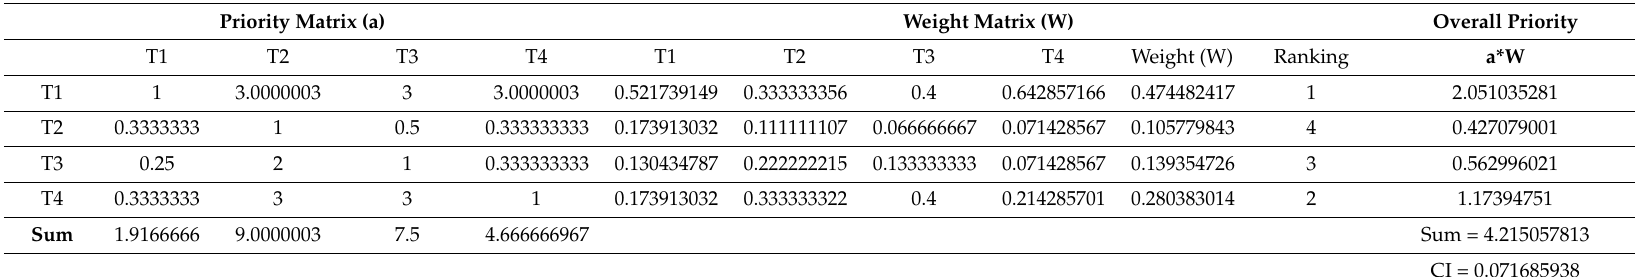
Table 6. Priority calculations for threat